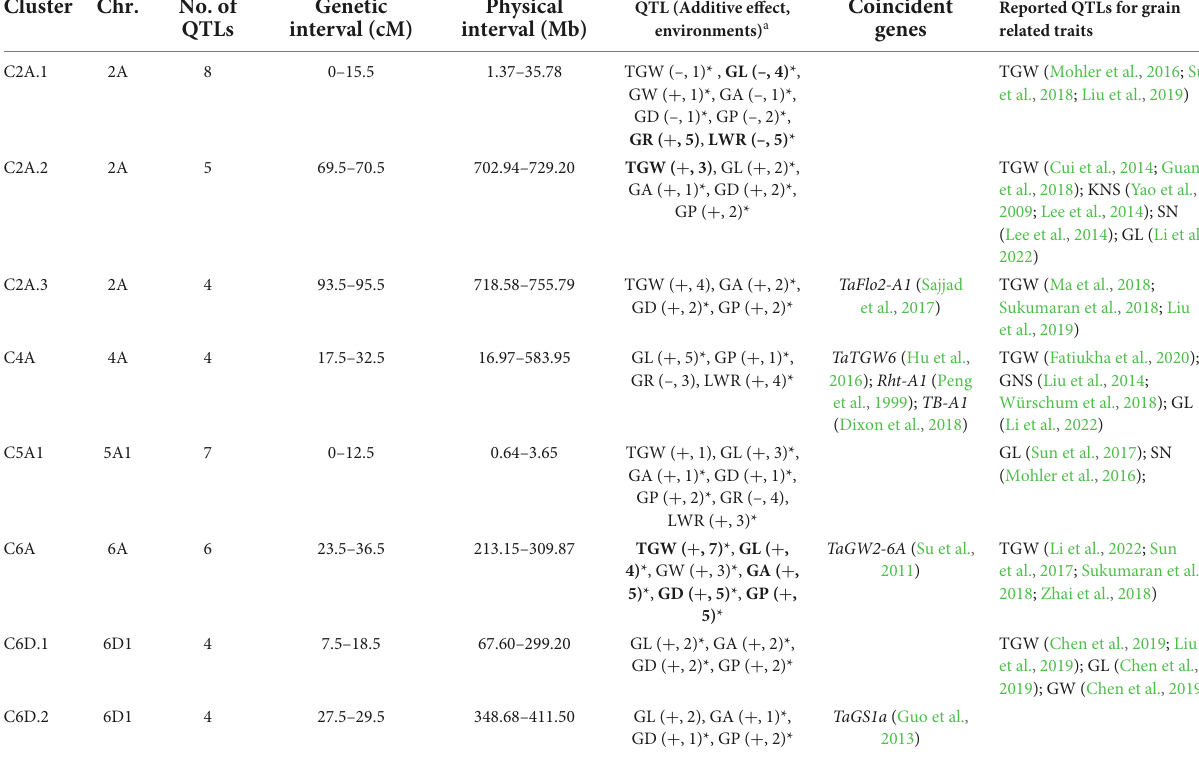
TABLE 2 Quantitative trait loci (QTL) clusters simultaneously affecting thousand grain weight (TGW) and grain-related traits (GRTs) in the BC-RILs. Cluster Chr.